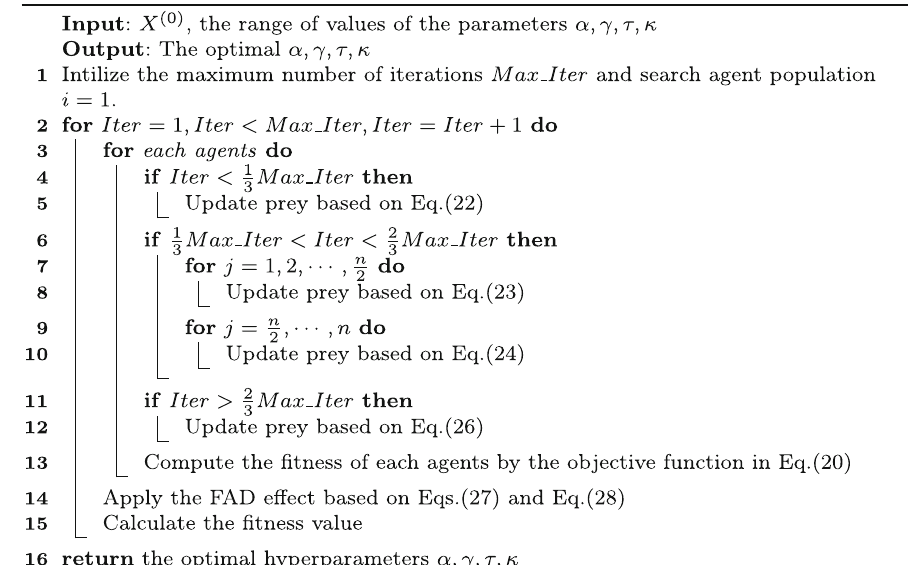
Fig. 3 The computational steps for the MPA algorithm-based ONGBM(1,1,k,c)